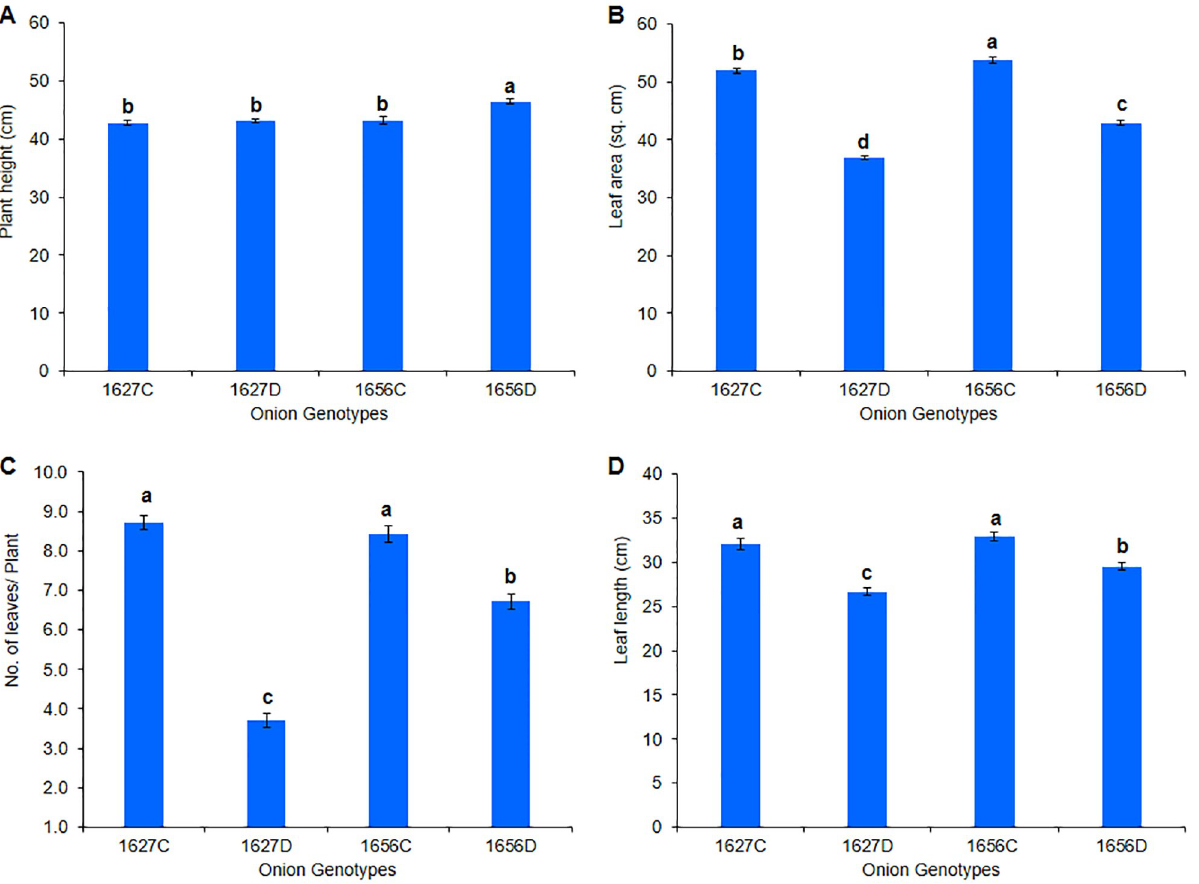
Fig 2. Diffrential morphological response in drought sensitive (1627) and tolerant (1656) onion genotypes. A. Plant height, B. Leaf area, C. Number of leaves, D. Leaf length.